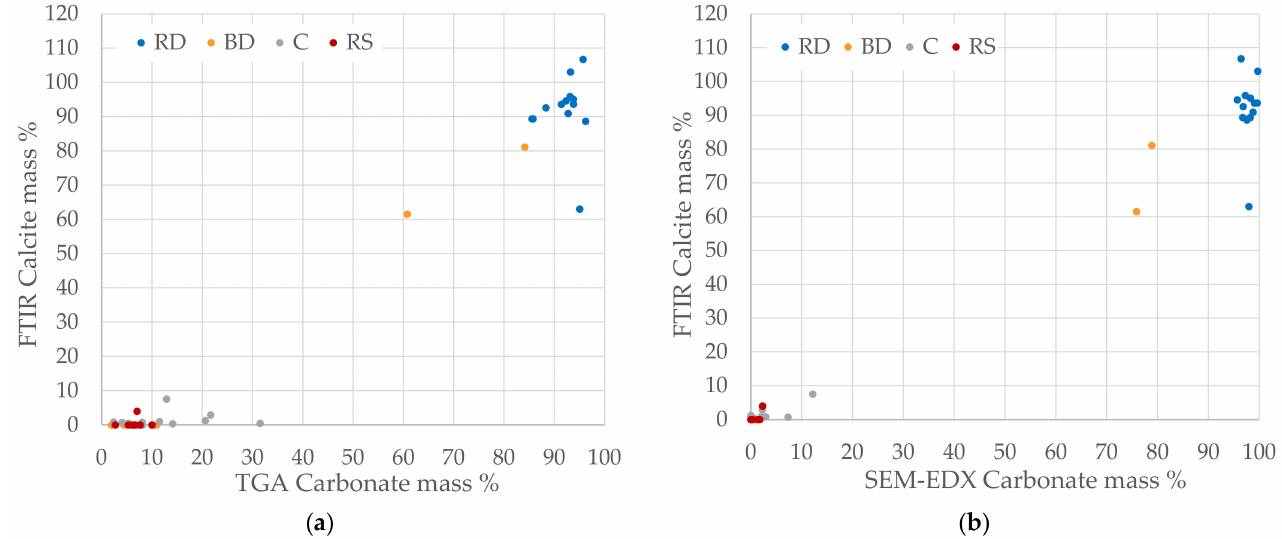
Figure 2. Comparison of FTIR-derived calcite % and ( a ) TGA- or ( b ) SEM-EDX-derived carbonate % for lab-generated respirable dust samples from RD, BD, C, and RS source materials ( n = 46 each). In total, none of the 13 RD samples; 10 of the 12 BD samples; 1 of the 11 C samples; and 9 of the 10 RS samples had calcite mass less than LOD for the FTIR; none of the samples had calcite mass between LOD and